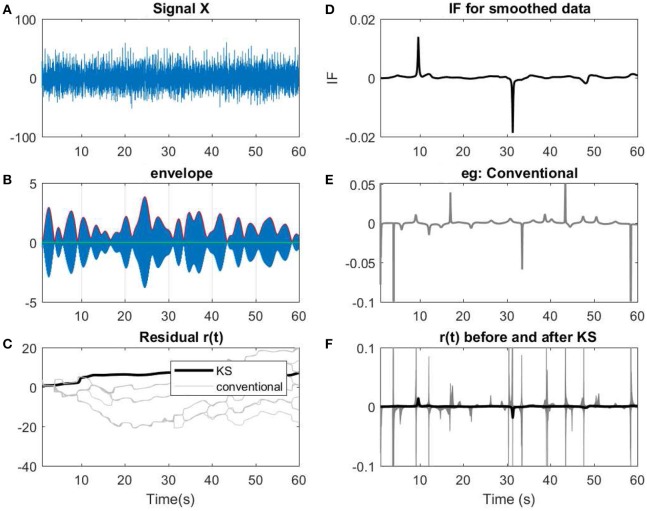
(A) A 60 s segment of measured EEG data. (B) Data has been narrow band-passed with a center frequency of 7 Hz. The envelope of the analytic band-passed signal has been plotted in red. (C) The residual of IP before and after applying KS has been applied. The term conventional corresponds to the filtered signals using a narrow band-pass filter before applying KS. As described previously, for every filter, a slight perturbation has been applied to the filter. (D) The IF of the smoothed data. (E) The resulting IF of one of the instances of the filtering process that has been applied on the data. As shown, in the conventional method, more spikes or variations are observed in te IF. (F) Comparing the IF of smoothed narrow-bandpassed signal (dark line) with IF of all the non-smoothed signals. The changes in regard to low envelopes in (B) can be observed as fewer abrupt changes after applying KS in the smoothed version than the conventional approach.